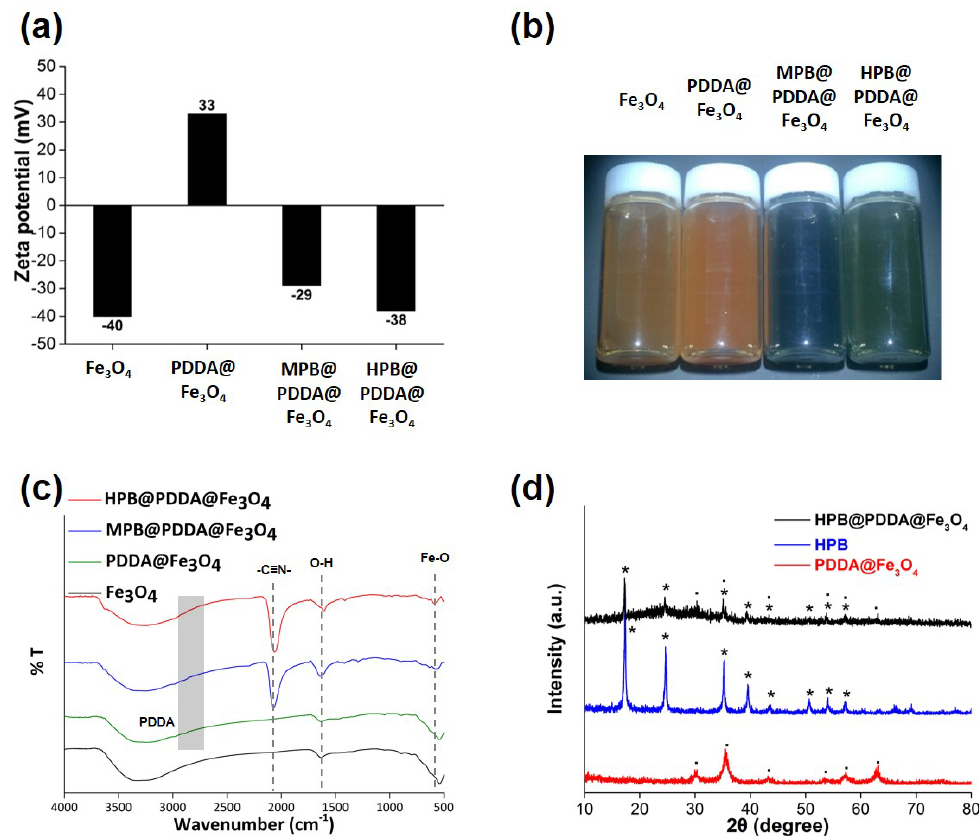
Figure 3. Representative ( a ) Zeta potential values; ( b ) Optical image; ( c ) Fourier-transform infrared spectroscopy (FTIR) spectra; and ( d ) XRD patterns of Fe 3 O 4 , PDDA@Fe 3 O 4 , mesocrystal Prussian blue